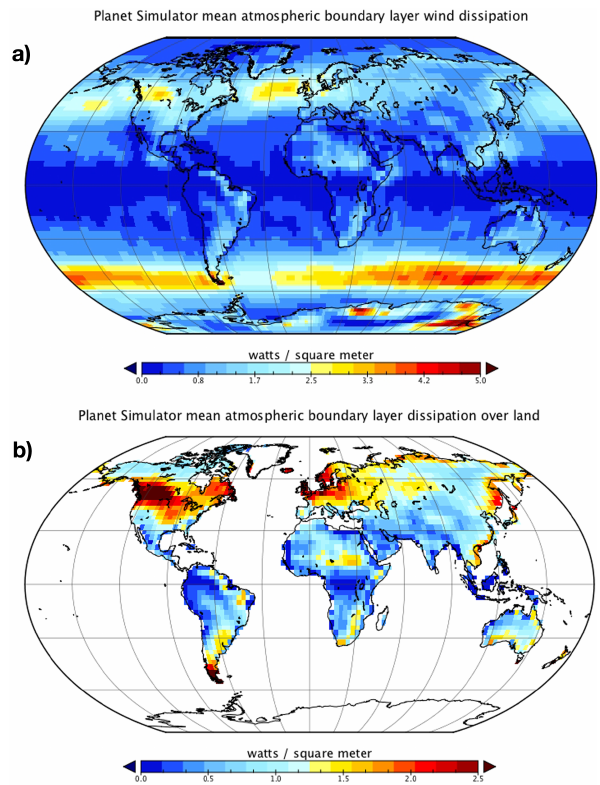
Fig. 6. Distribution of boundary layer wind dissipation a) glob- ally and b) over non-glaciated land as a proxy for wind power ex- tractability simulated by a general circulation mode at T42 resolu- tion and 10 vertical layers.